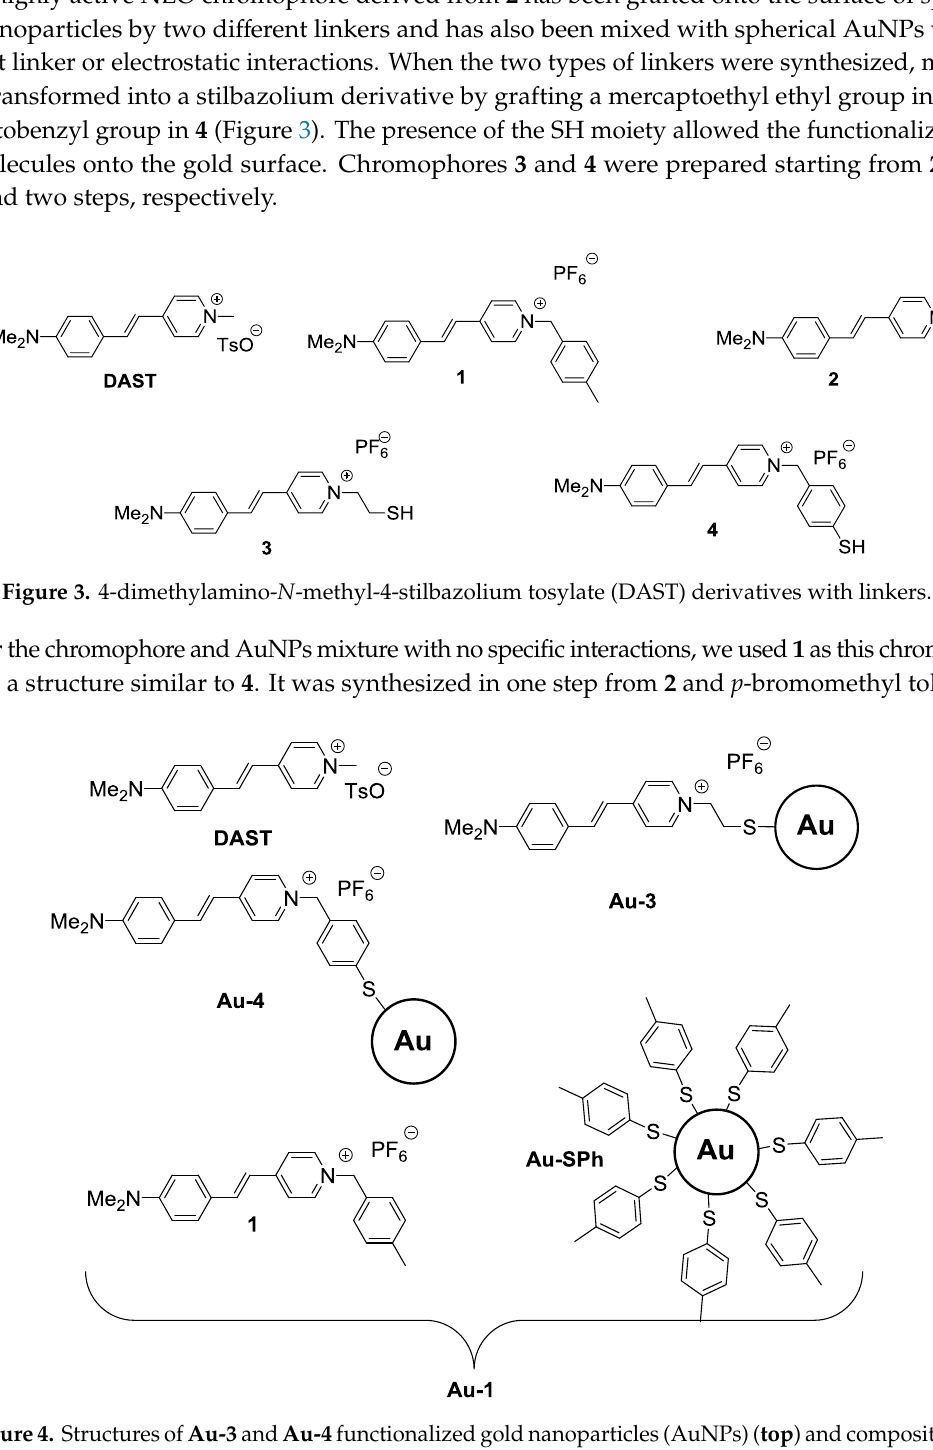
Figure 3. 4-dimethylamino- N -methyl-4-stilbazolium tosylate (DAST) derivatives with linkers.